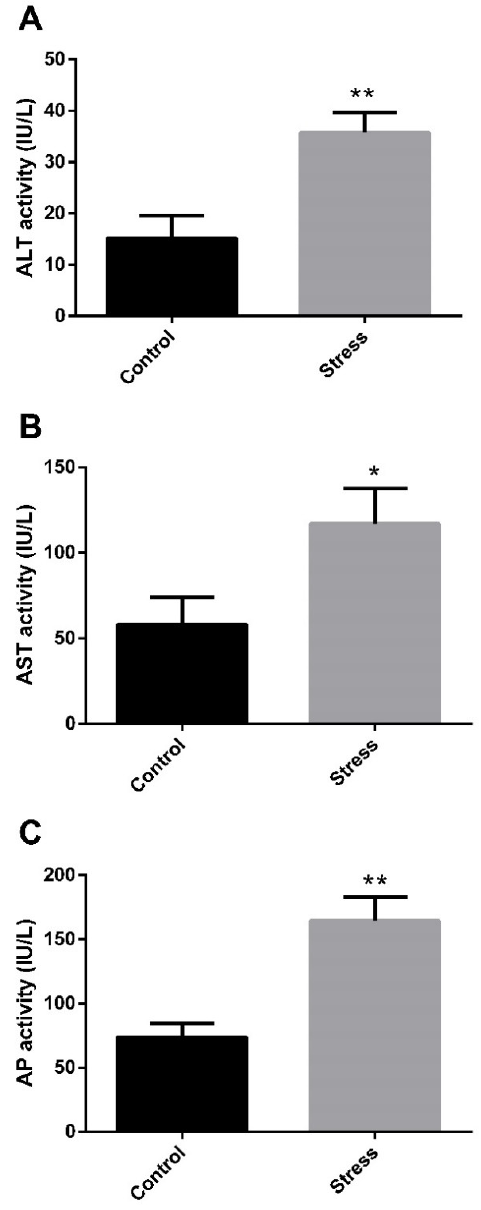
Figure 1. Plasmatic activity of alanine aminotransferase (ALT), aspartate aminotransferase (AST), and alkaline phosphatase (AP) in control and high-temperature stress groups of G. chilensis. Levels of ALT ( A ), AST ( B ), and AP ( C ) activity are expressed in IU/L. Bars represent the mean ± SEM. Significant differences between the control and stress groups are indicated by asterisks; * ( p < 0.05) and ** ( p < 0.01).